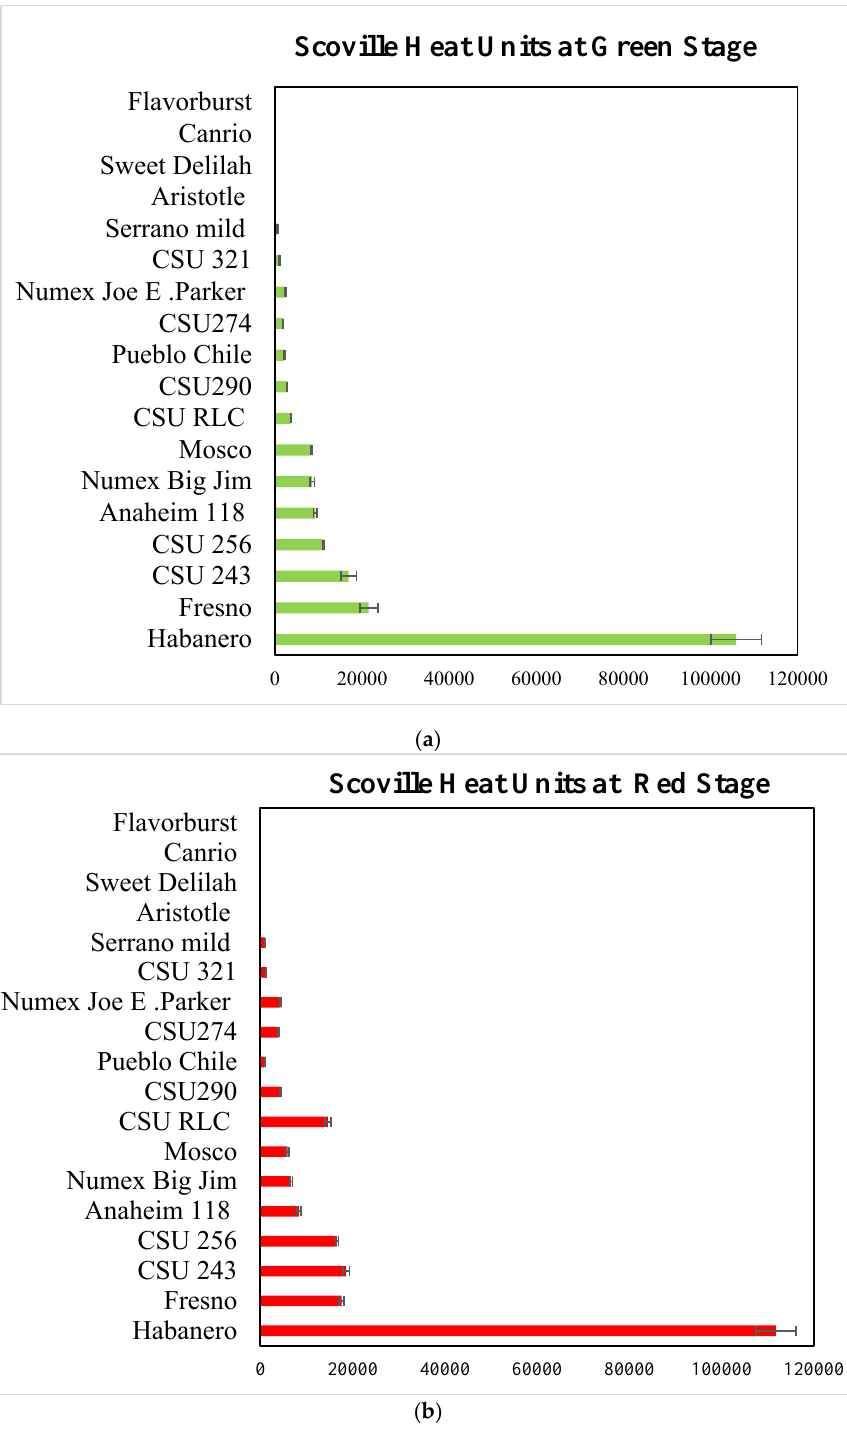
Figure 4. ( a ) Total capsaicinoids content estimated in C. annuum and C. Chinense genotypes in green pepper pods in Scoville heat units (SHU). ( b ) Total capsaicinoids content estimated in C. annuum and C. Chinense genotypes in red pepper pods in Scoville heat units (SHU). The significance level was set at p < 0.05. Bars represent stand deviation (SD).